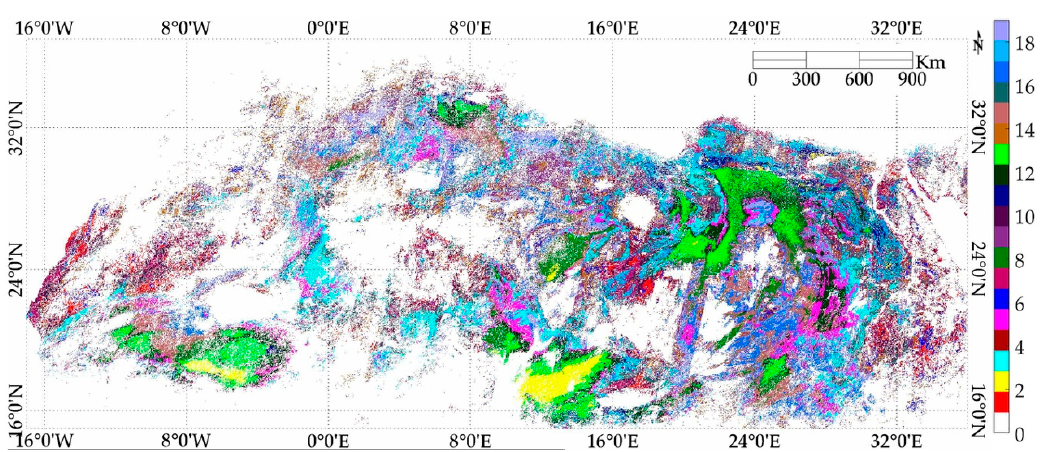
Figure 1. K-Means Classification of North Africa to 5% Spatial Uncertainty.